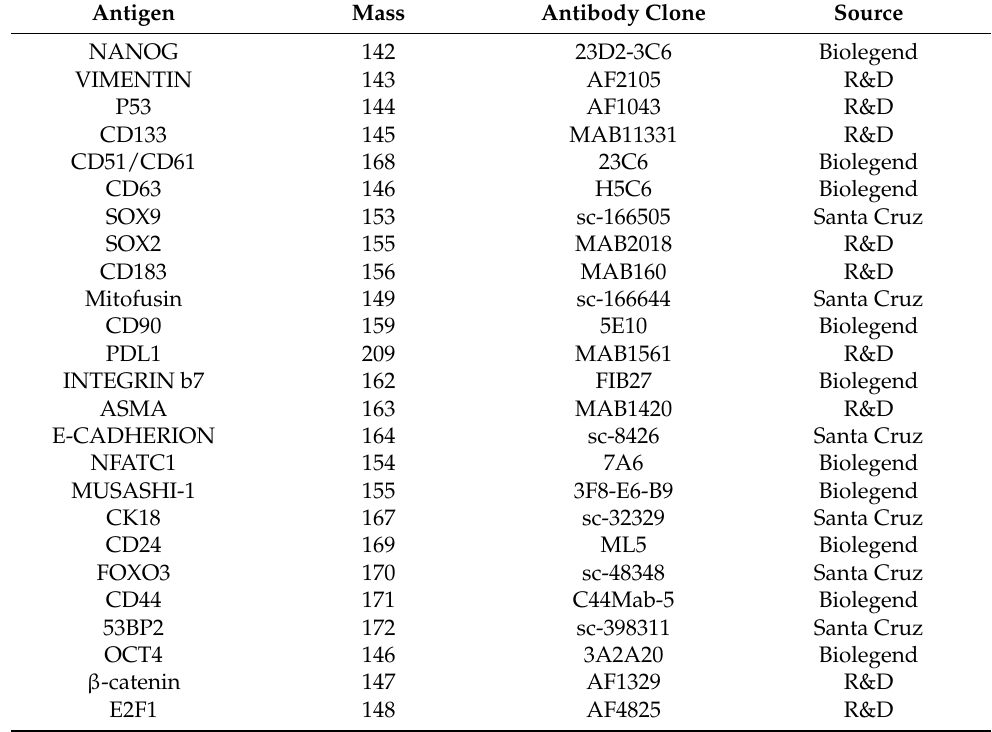
Table 1. Antibodies used for